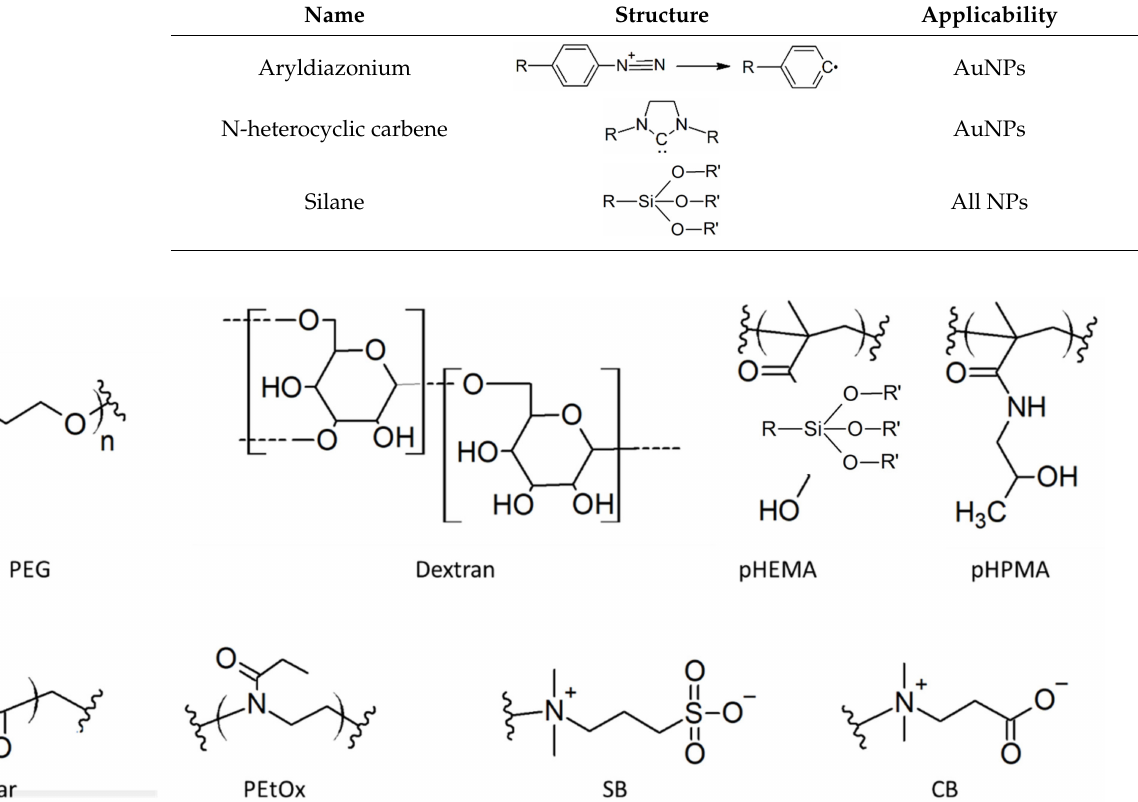
Figure 4. Structures of the solubilizing functions commonly used in the surface chemistry of inorganic